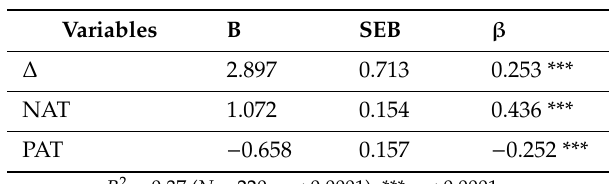
Table 8. Standard regression analysis summary for variables predicting emotion dysregulation.